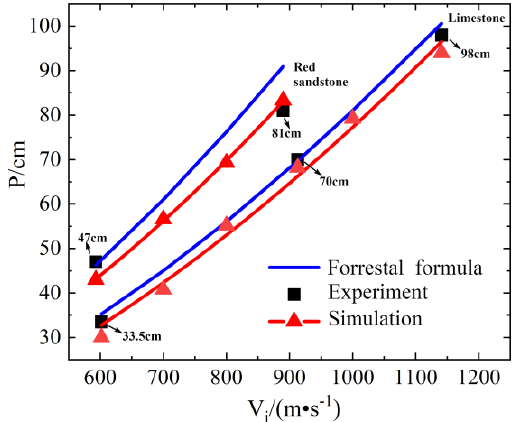
Figure 7. Effect of velocity on penetration depth. Table 7. Red sandstone and limestone penetration depth data.